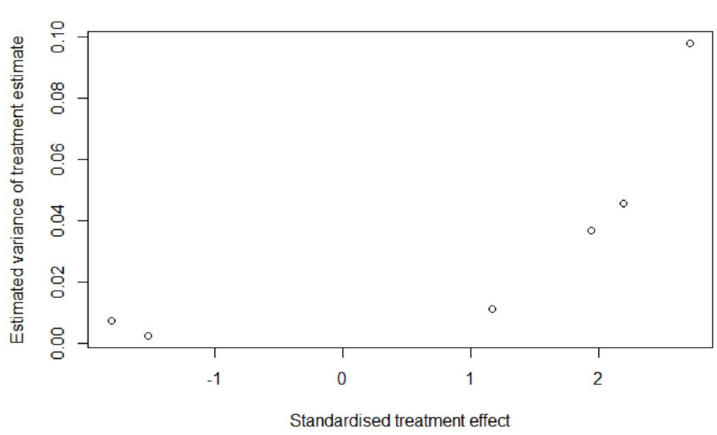
Fig 7. Publication bias assessment: Funnel plot for post hoc meta-analysis of tuberculosis and risk of cardiovascular disease and related mortality.